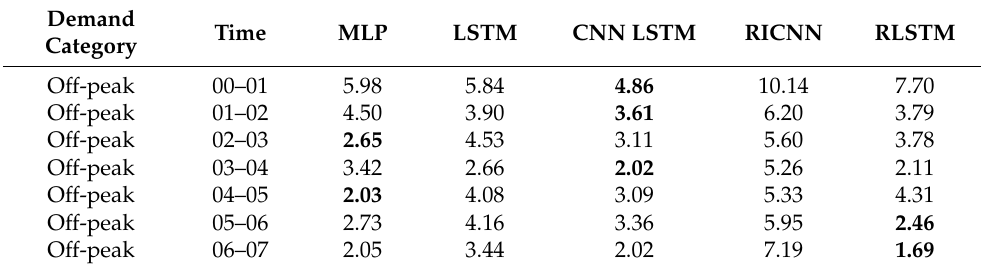
Table 8. MAPE results by hour for each tested model. The text in bold denotes the best performance for each